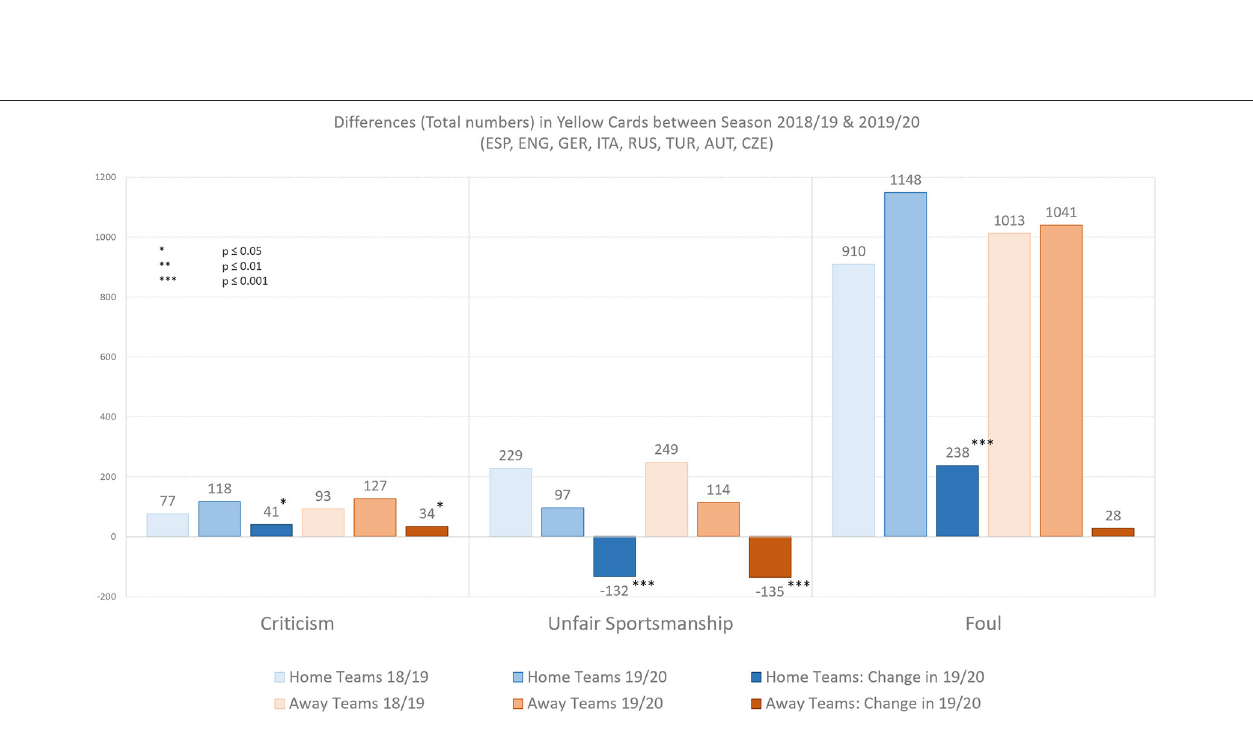
FIGURE 4 | Absolute differences in Criticism, Unfair Sportsmanship, and Foul Play. Illustration shows yellow cards (criticism, unfair sportsmanship, and foul play) awarded to home and away teams in the top football leagues of Spain, England, Germany, Italy, Russia, Turkey, Austria, and Czech Republic. Bar plots are based on aggregated match results statistics of rounds played in the leagues as ghost games (no or strongly limited attendance) in season 2019/20 and respective rounds of regular matches (regular attendance) in season 2018/19 ( N =